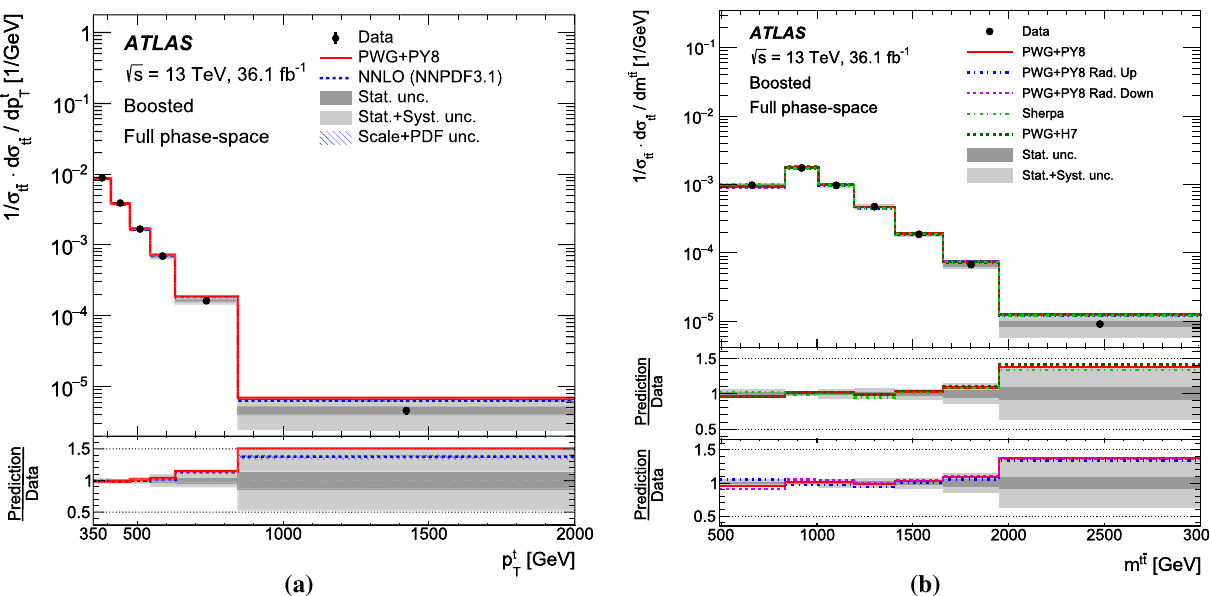
Fig. 66 a Parton-level normalised differential cross-section as a func- tion of p t in the boosted topology, compared with the NNLO predic- T tions obtained using the NNPDF3.1 NNLO PDF set and the predictions obtained with the Powheg + Pythia8 MC generator. The hatched band represents the total uncertainty in the NNLO prediction. b Parton-level